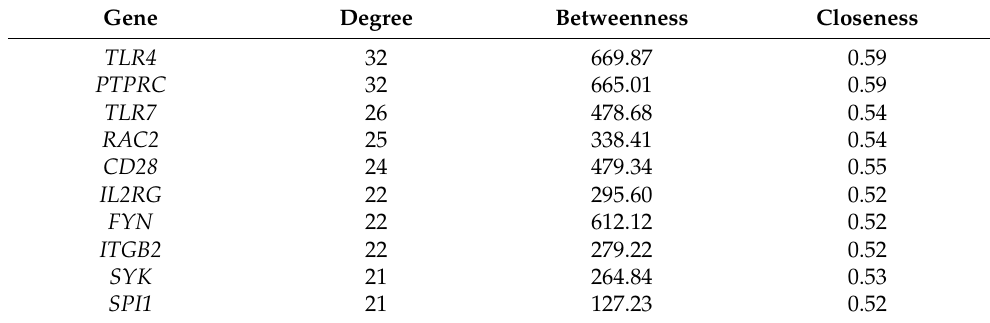
Figure 6. PPI network of immune-system-related upregulated DEGs. The size of each node is based on degree value; a bigger size is related to a larger degree value. The color of each node is related to one of two subnetwork modules that were obtained (green and pink). Table 5. The nodes with the top 10 highest topology scores were calculated with three centrality methods.